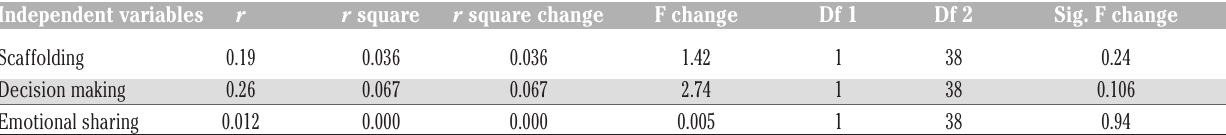
Table 8. Regressions for the TMA ( test multidimensionale dell'autostima ) interpersonal scale. Independent